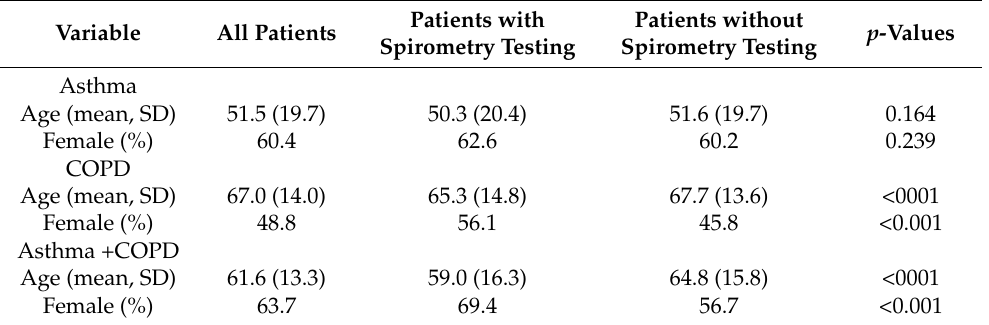
Table 1. Age and sex characteristics of asthma and COPD patients with and without spirometry testing.